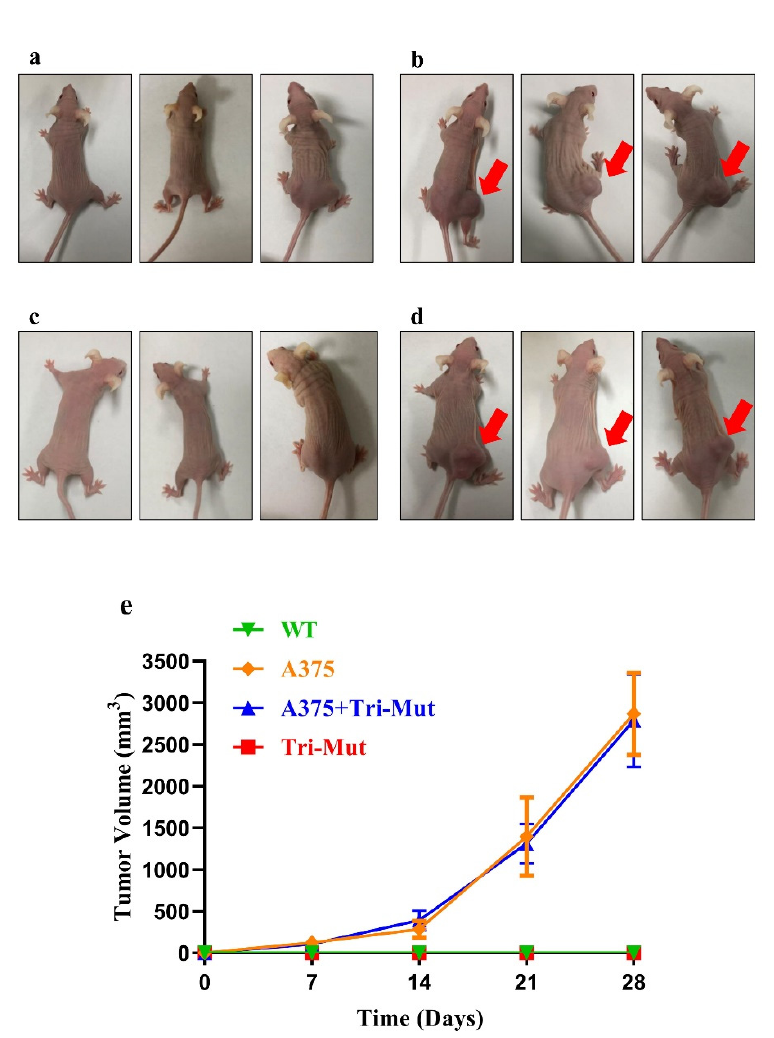
Figure 5. Subcutaneous tumorigenicity test with BALB/c nu/nu mice. Images of mice 28 days after subcutaneous injection: ( a ) control group (without injection), ( b ) A375-injected mice, ( c ) Tri-Mut cell-injected mice, ( d ) A375 + Tri-Mut cell-injected mice. ( e ) Tumor volume at 4 time points after subcutaneous injection in different groups.